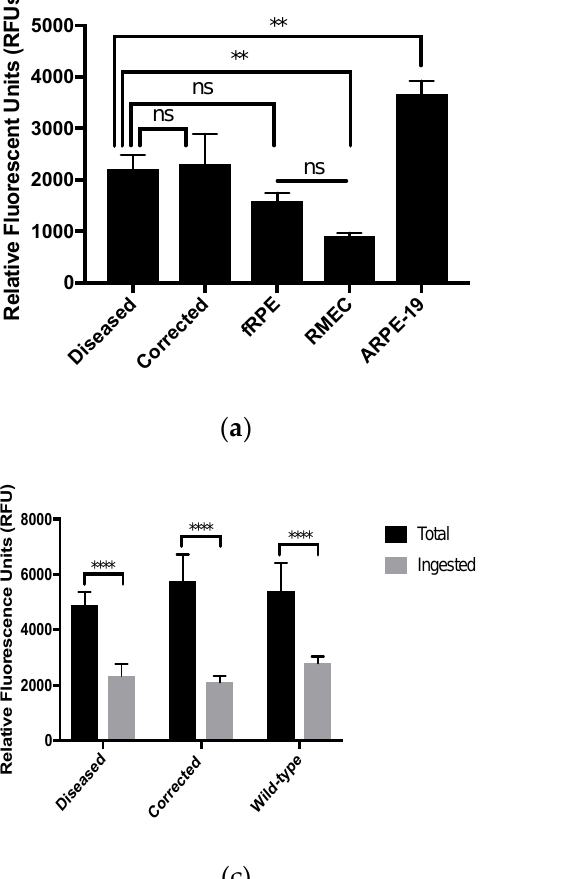
Figure 6. Atrophy of RPE cells upon extended passage. RPE cells were passaged enzymatically at each time point shown at a seeding density of 1 × 10 5 cells per cm 2 and allowed growing for 5 to 30 days